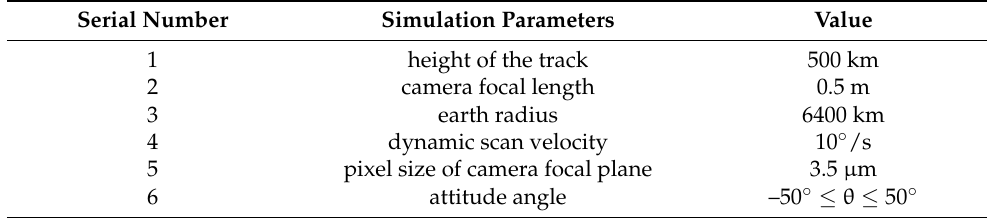
Table 1. Simulation